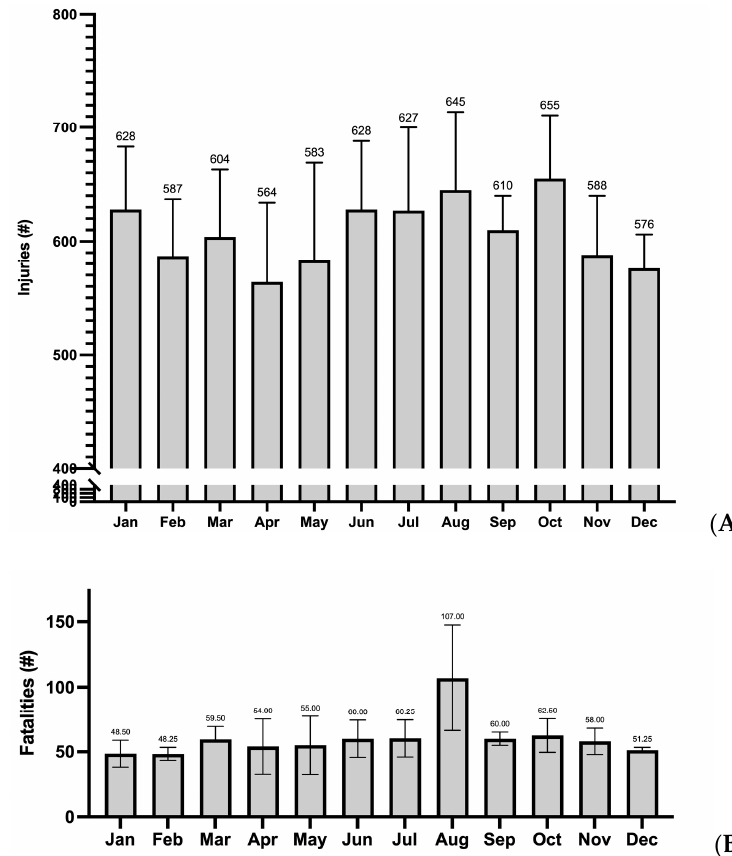
Figure 2. Average number of accident-related severe injury per month (2015–2020). ( A ) Average number of accident-related fatalities per month (2017–2020). ( B ). Note: number above each bar = average number of injuries/fatalities each month.